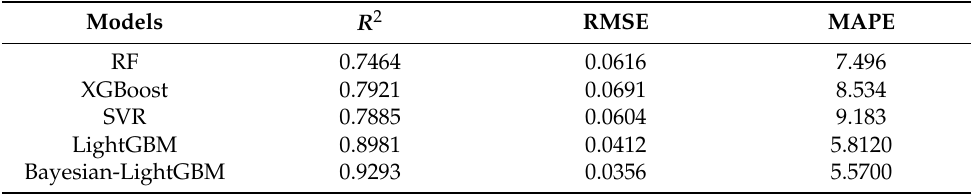
Figure 16. Compare the proposed model with other models. ( a ) The fitting result between the predictive value of the XGBoost and the observed value. ( b ) The fitting result between the predictive value of the RF and the observed value. ( c ) The fitting result between the predictive value of the SVR and the observed value. ( d ) The fitting result between the predictive value of the Bayesian-LightGBM and the observed value. Table 7. The evaluation results of friction coefficient prediction model.